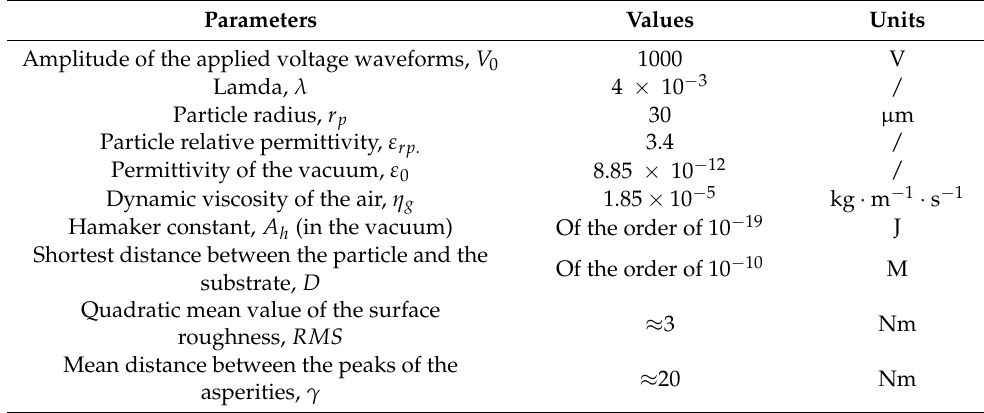
Table 1. Values of various parameters used during simulation.